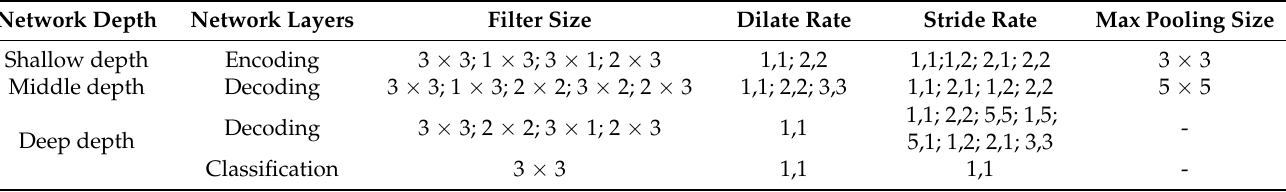
Figure 5. Layer spatial size-based approach of the proposed ThelR547v1 network. Table 5. Summary of the ThelR547v1 configuration.